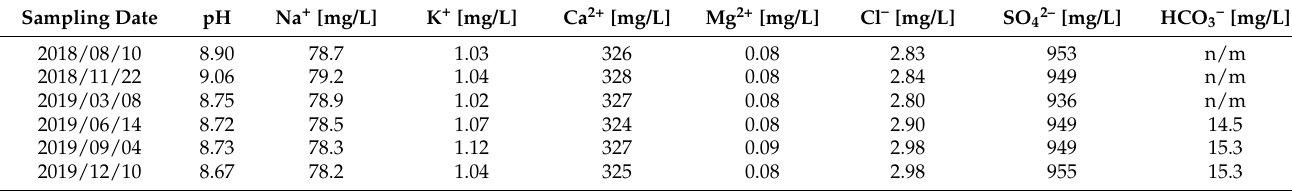
Table 3. Chemical composition of the Futamata hot